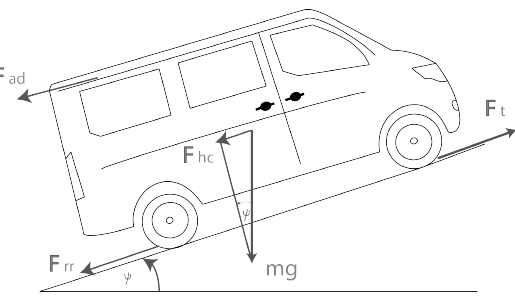
Figure 5. The forces acting on the electric vehicle along a